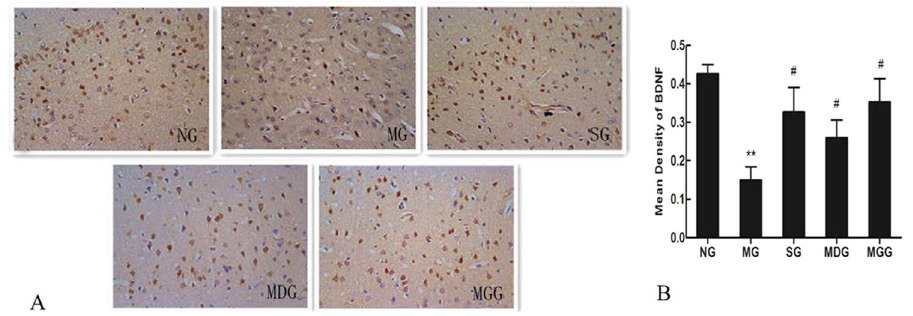
Figure 4. Effects of meloxicam on BDNF protein expression in CUMS rat cortices. ( A ) Changes in BDNF expression in rat cortex. ( B ) Changes in the mean density of BDNF protein expression of rat cortices. NG: normal group. MG: CUMS group. SG: Sertraline group. MDG: Meloxicam (1 mg.kg − 1 ) group. MGG: Meloxicam (3 mg.kg − 1 ) group. Group data shows the changes in BDNF protein expression. Data are expressed as